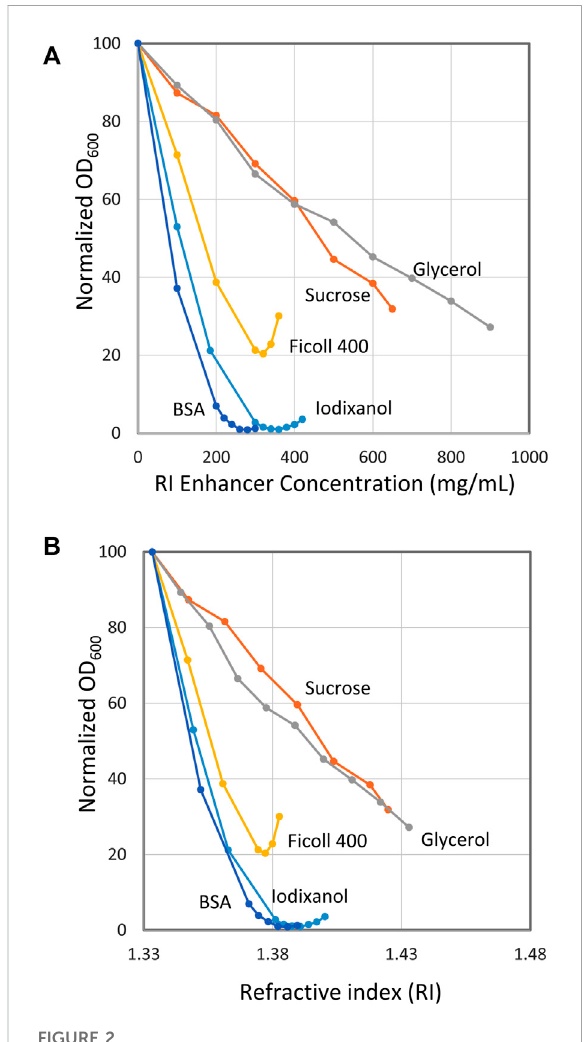
FIGURE 2 Effect ofrefractiveindex(RI)enhancerson theopticaldensity of suspensions of E. coli . (A) Optical density as a function of enhancerconcentration. (B) OpticaldensityasafunctionofRI.The xaxisgivesthenormalizedopticaldensity(OD 600 =100 at0% RI enhancer concentration). Bacteria stock suspensions were mixed with RI enhancer and bufferto give a fi nal volume of500 µL with the indicated RI enhancer concentration. The stock bacteria suspensions used for the different curves in the diagram had an OD 600 of 20 – 42 (extrapolated). The stock suspension volumes (5 – 100 µL) were chosen to give readings below 1.5 to secure optical